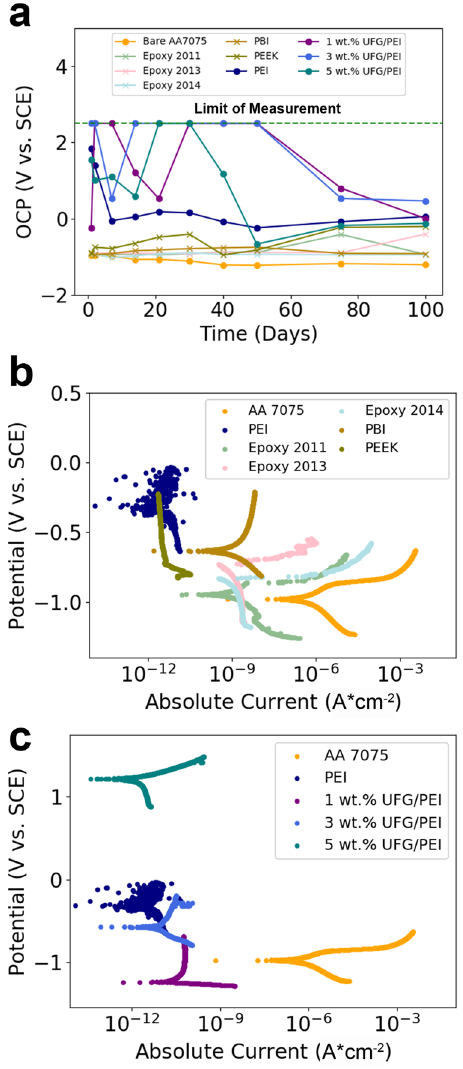
Fig. 3 OCP and Tafel Analysis of Coated Substrates. a Evolution of OCP measured 100 days for abraded AA 7075, fi ve benchmark polymeric coatings, and four PEI and UFG/PEI coatings. The coated substrates have been immersed in 3.5 wt.% aqueous NaCl solutions under ambient conditions. b Tafel plot of AA 7075, three epoxy formulations, PEEK, PEI, and as-cast PEI. c Tafel plot of as-cast PEI, and 1, 3, and 5 wt.% UFG/PEI